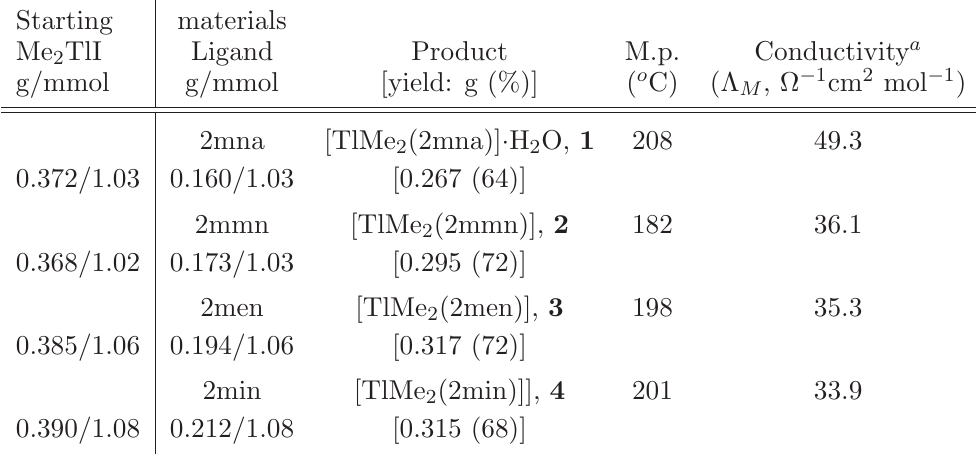
Table 1 Preparation data and some physical properties for [TlMe 2 (L)]